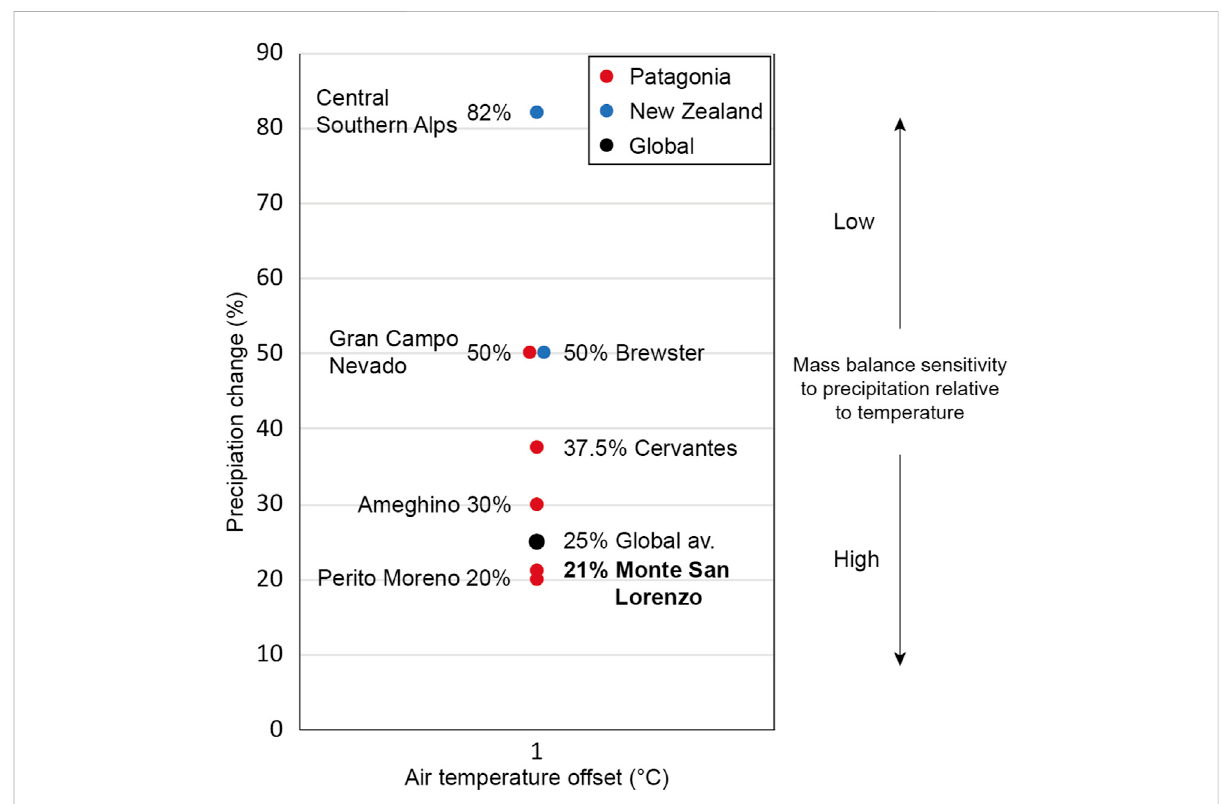
FIGURE 10 Precipitation change equivalent to 1 ° C change in air temperature at glaciers in Patagonia and New Zealand and a global average (black circle (Oerlemans, 2005),). Red circles are glaciers in Patagonia at Perito Moreno, Ameghino and Cervantes glaciers on the eastern side of the Southern Patagonian Andes (Bippus, 2007) the Gran Campo Nevado ice cap in southern Patagonia (53 ° S) (Möller et al., 2007) and the MSL ice cap (this study). Blue circles are glaciers in New Zealand ’ s Southern Alps at Brewster Glacier (Anderson et al., 2010) and an average of a collection of glaciers from the central Southern Alps, including Franz Joseph, Fox and Tazman Glaciers (Anderson and Mackintosh,